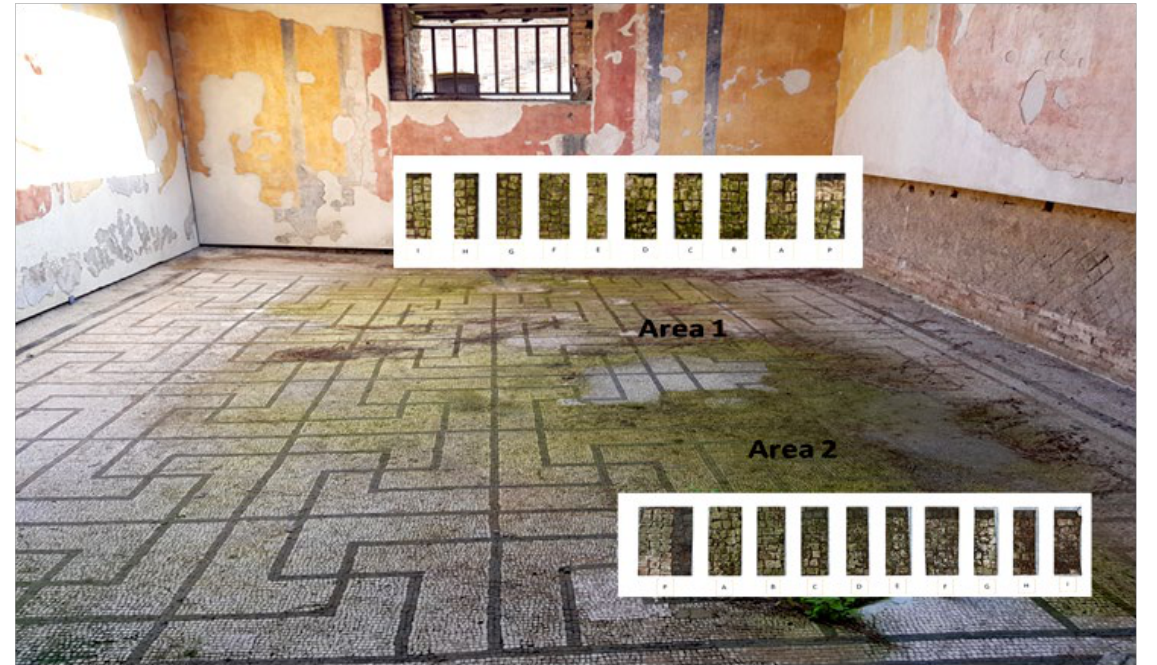
Figure 2. XIX room of “Insula delle Muse”: areas of experimentation with the indication of the ten tested EOS and products. Area 1 and Area 2 were each divided in zone P, A, B, C, D, E, F, G, H and I treated respectively with Preventol ® RI50, Eucaliptus, Basil, Essenzio, Cloves, YOCOCOIL, Biotersus, Thyme, Pine tree and Tea tree oil.